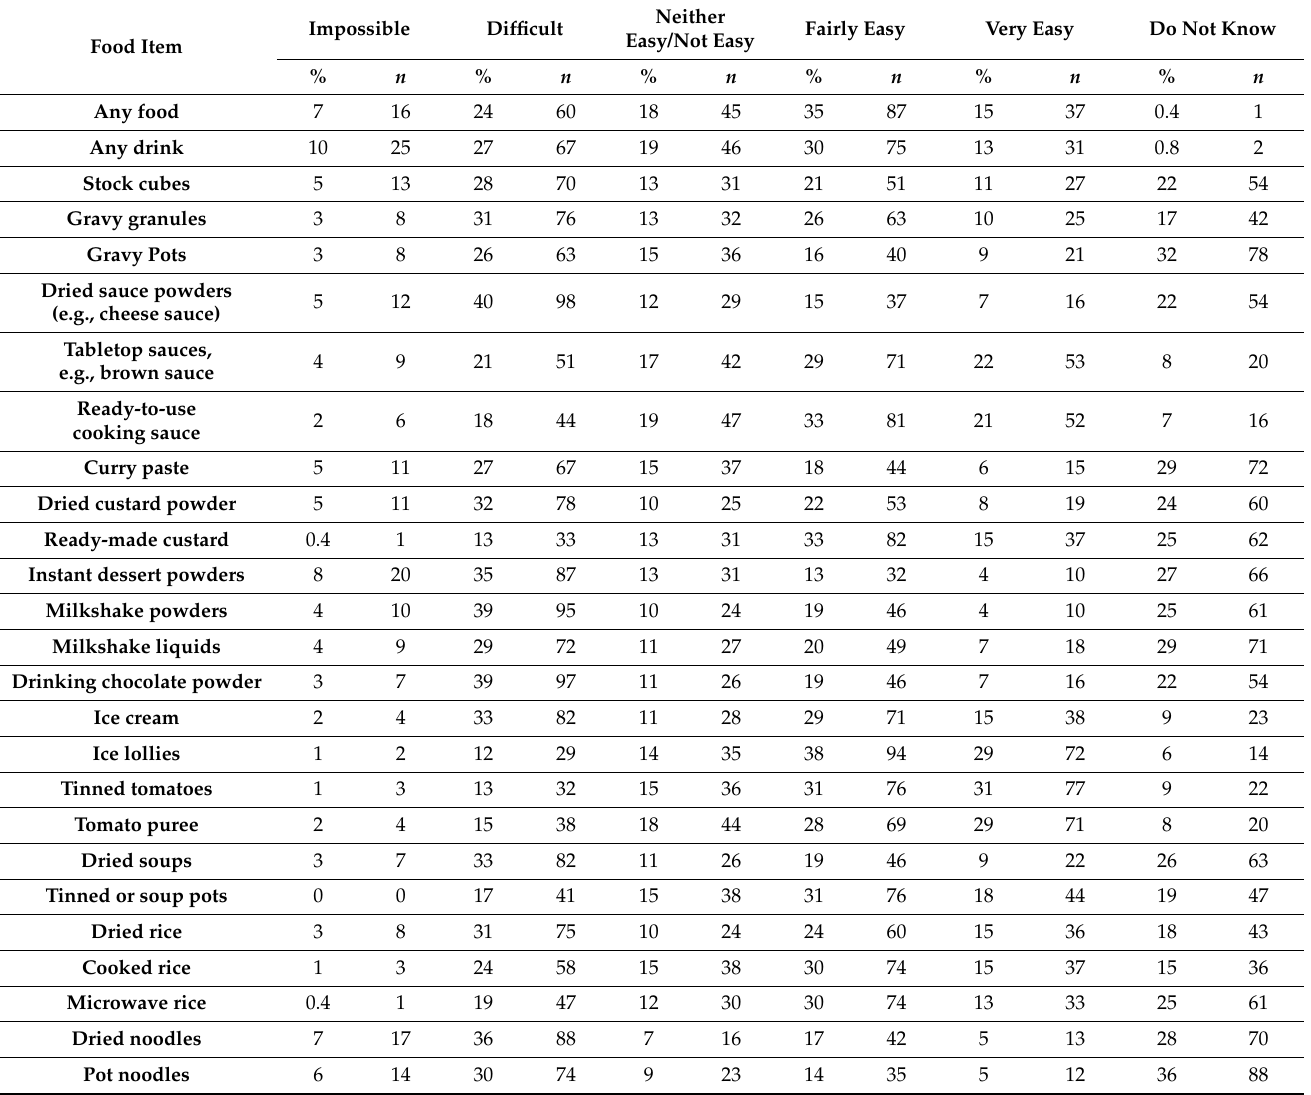
Table 1. Rating of interpretation of protein exchanges from food labels by respondents ( n = 246) for food and